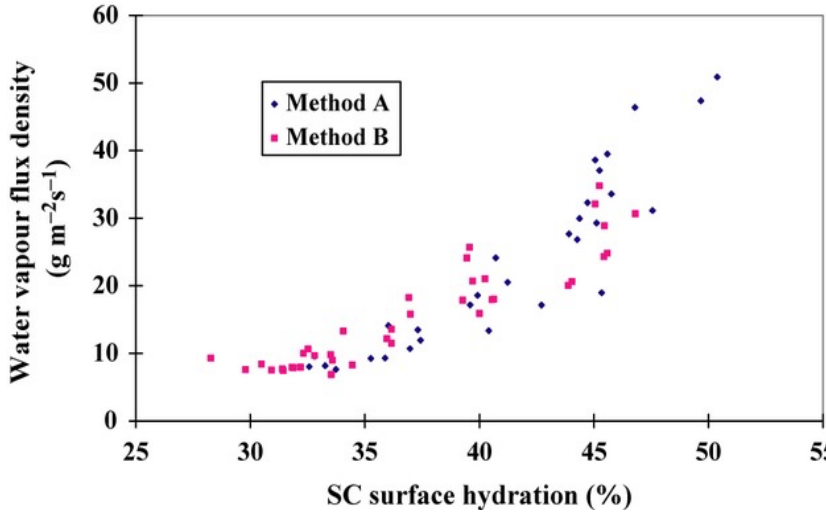
Figure 2. Water vapour flux density (WVFD) data (Method A) versus opto-thermal transient emission radiometry (OTTER) (Method B) from the volar forearm